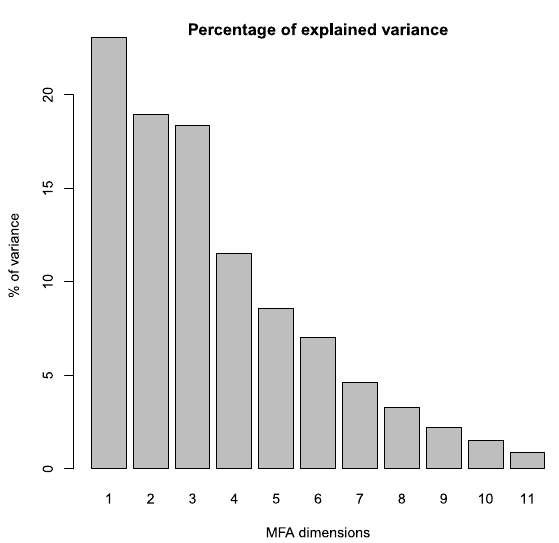
Fig. 3. Percentage of variance explained by the dimensions after Multiple Factor Analysis (MFA) of the three groups: clinical, neu- ropsychological and EEG variables.